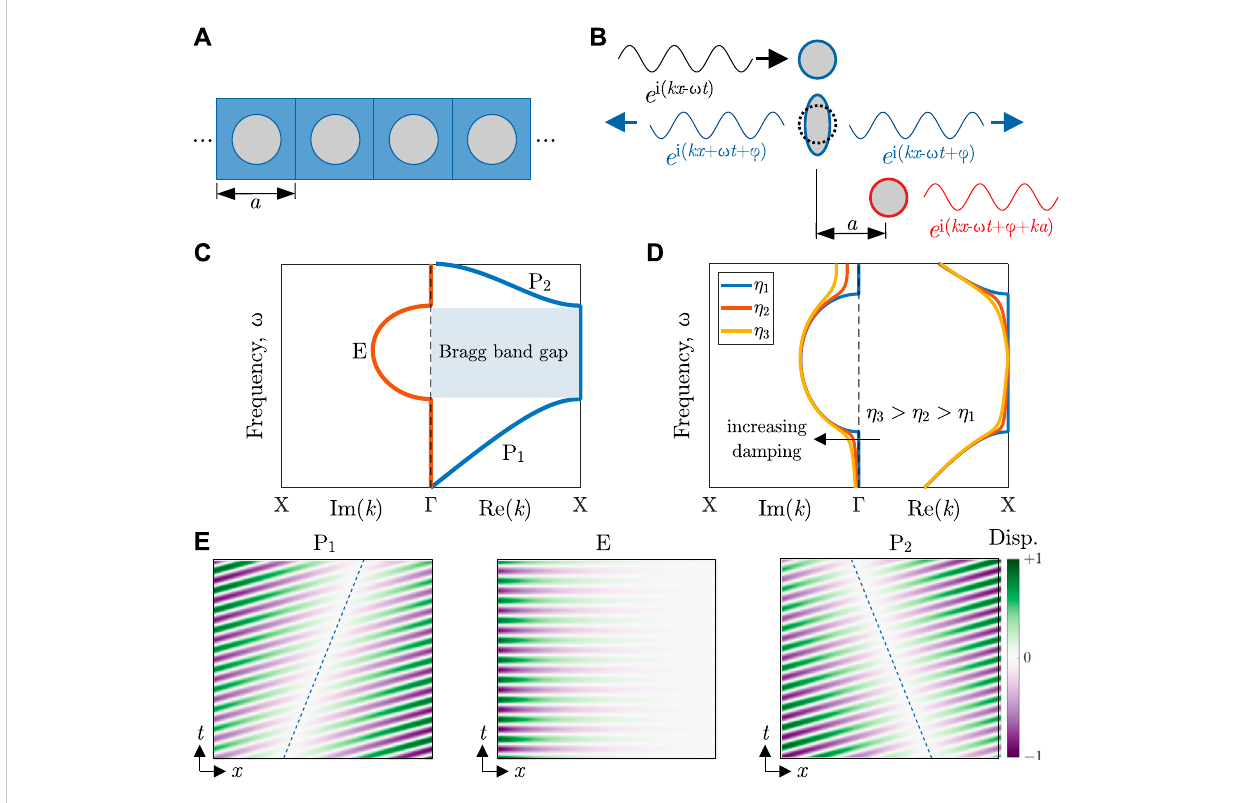
FIGURE 1 One-dimensional PC and Bragg scattering phenomenon. (A) Example of one-dimensional PC composed of scatterers (grey circles) with a unit cell with length a in a matrix material (blue area). (B) Incident wave (black line) on scatterer and subsequent radiated wave (blue line), which is combined with the wave radiated by the contiguous scatterer (red line). (C) Dispersion relation (curves) and Bragg band gap (highlighted region), with distinct branches markedasP 1 ,E,andP 2 . (D) Exampleoftheeffectofincreasingvaluesofdamping( η )onthedispersioncurves. (E) Examplesof(P 1 )positivephaseand groupvelocities(E)spatialdecayofwavesexcitedinsidethebandgap,and(P 2 )positivephasevelocityandnegativegroupvelocity.Thecolorbarindicates normalized